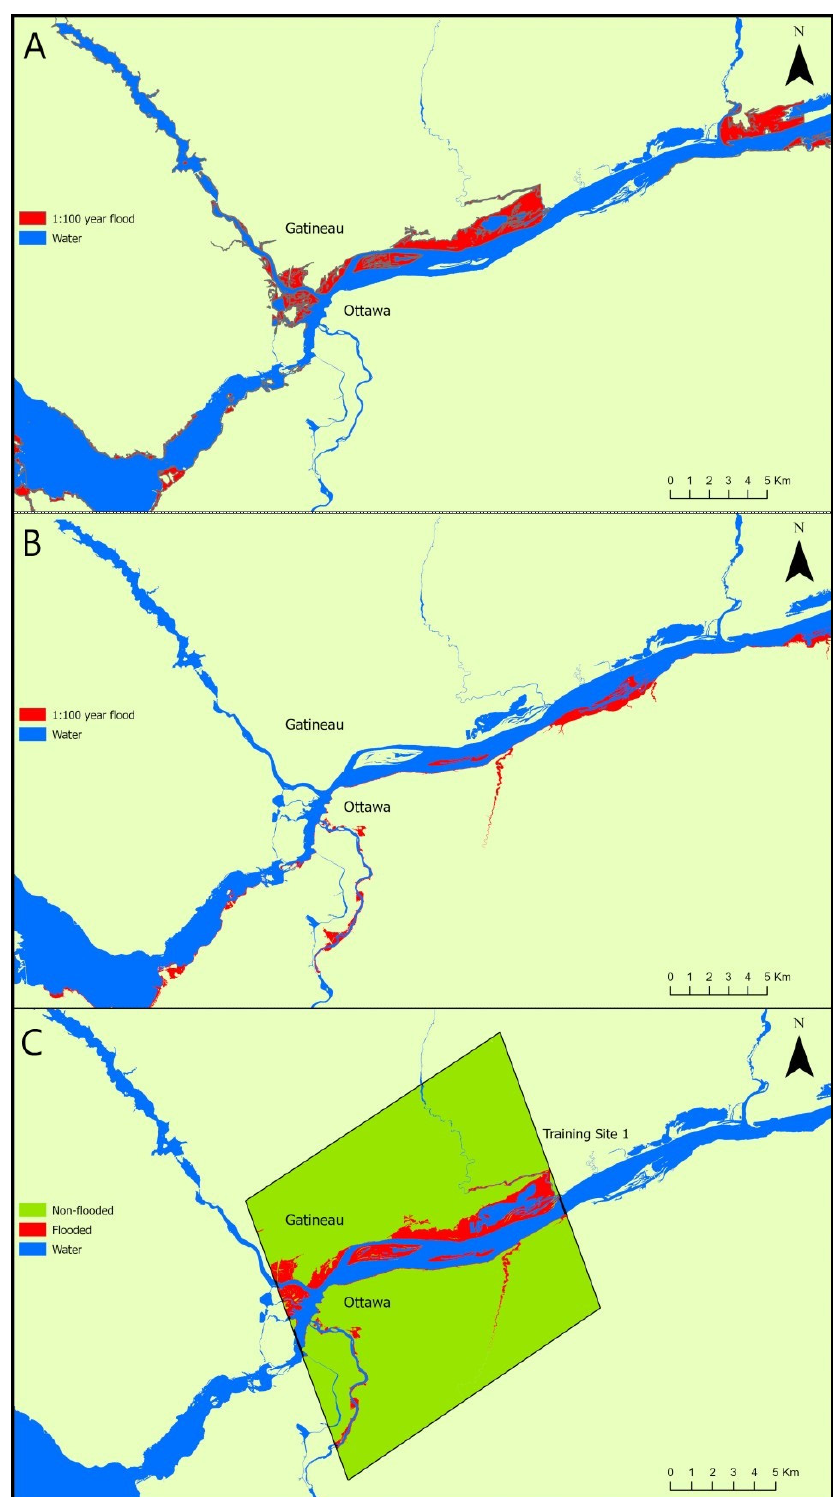
Figure 2. ( A ) FDRP 100 year flood hazard maps on the Ontario and Quebec side (1980s) with spatial gaps; ( B ) RVCA 100 year flood hazard map for the Ontario side (continuous); and ( C ) Training site 1 for random forest classification. Flood hazard maps are compiled from the FDRP (for Quebec side) and RVCA maps (for Ontario